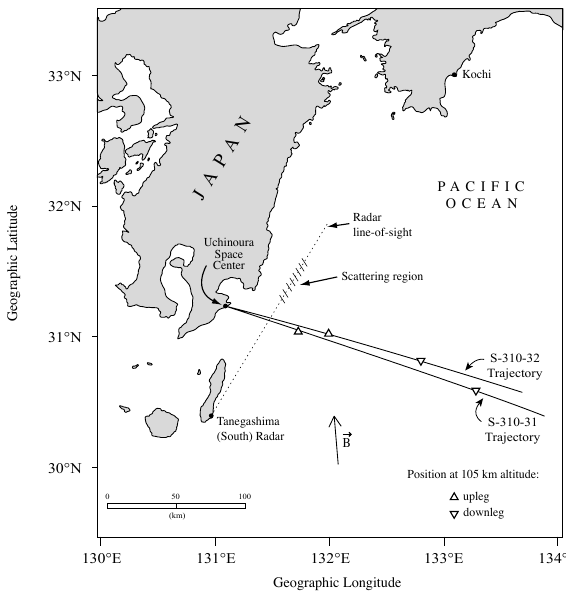
Fig. 1. Horizontal projection of the trajectories of the SEEK-2 sounding rockets and the Tanegashima south radar